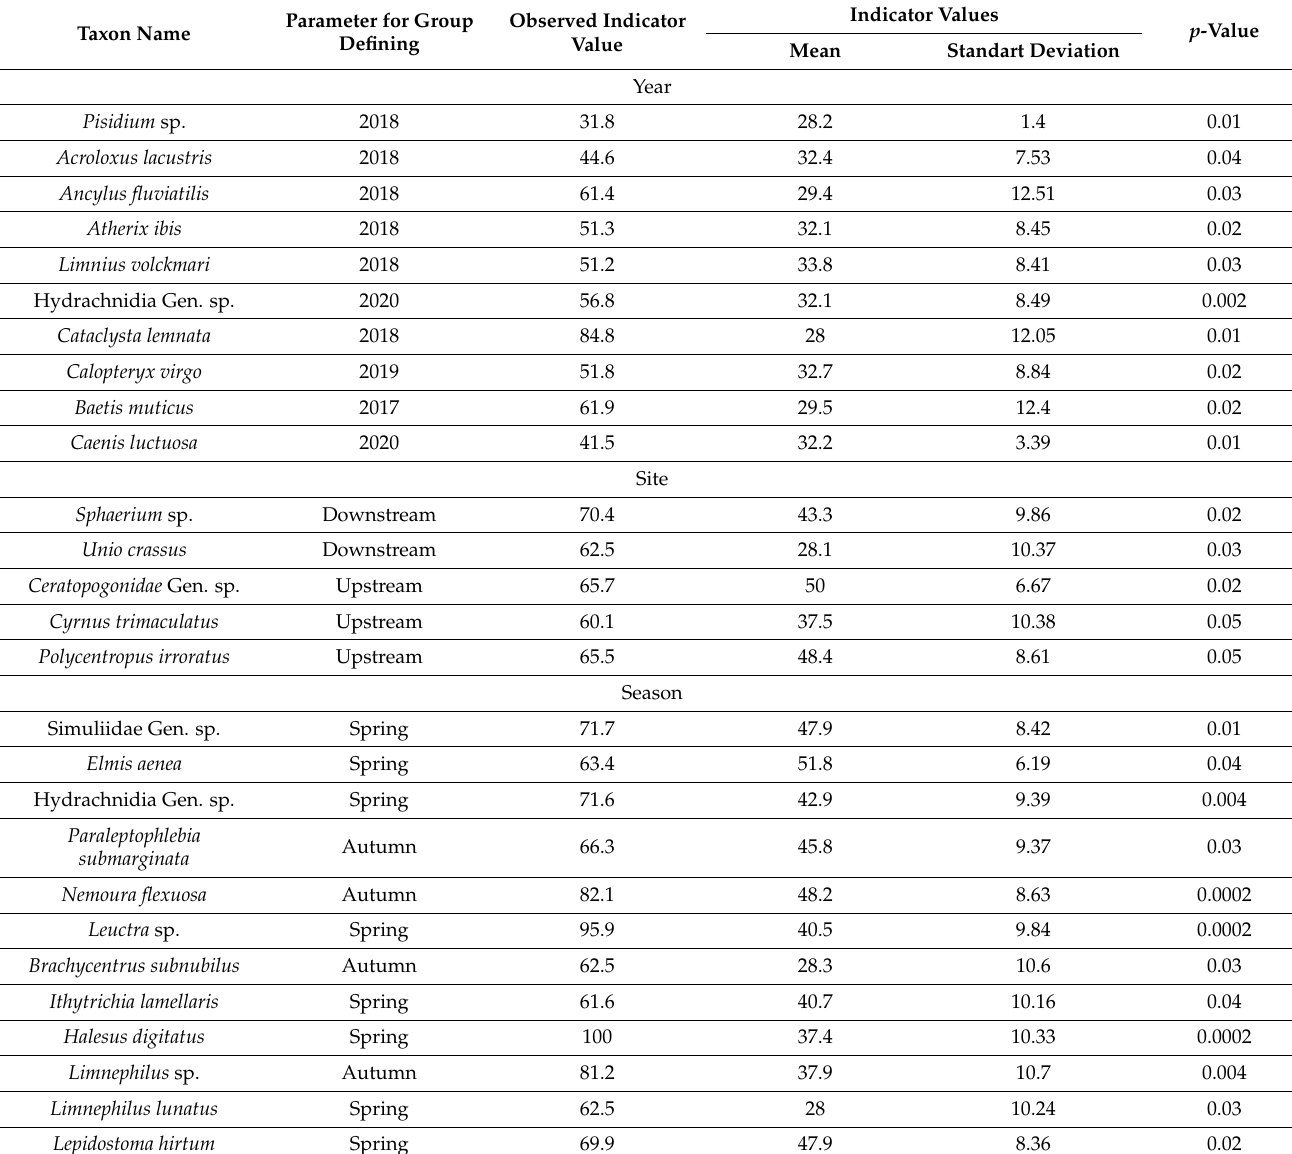
Table 3. Indicator species analysis of the Age, showing indicator values of significant indicator species (groups are defined by year, season, and stream